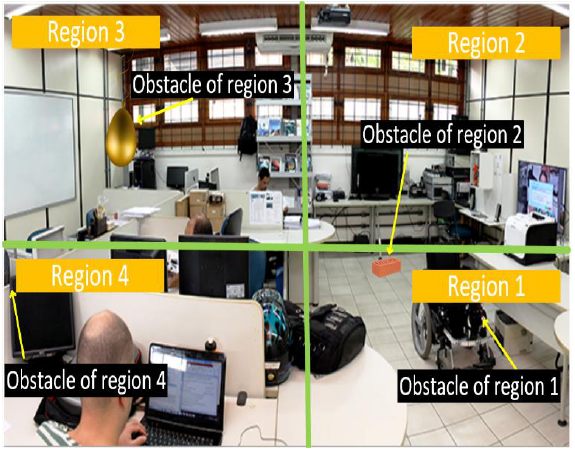
Figure 12. Visual markers under different lighting.